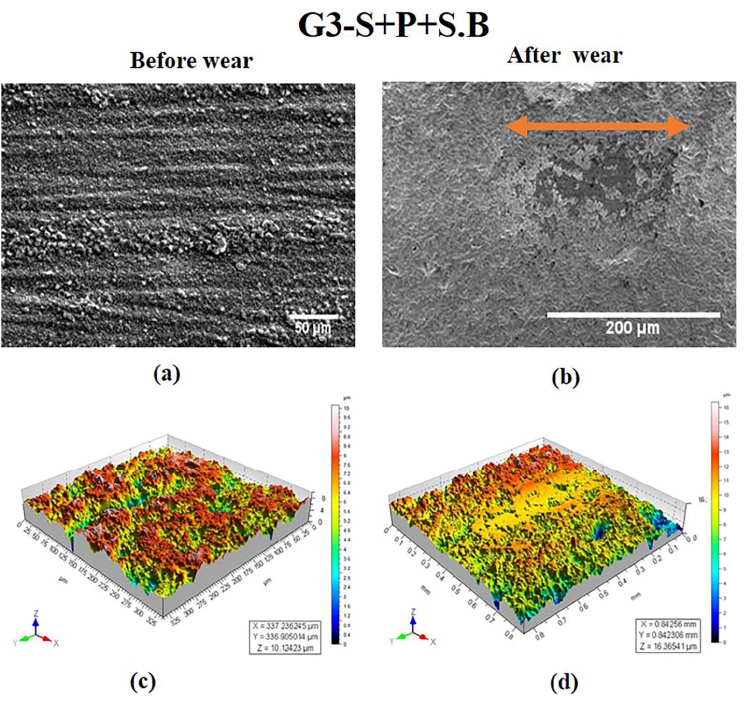
Figure 4. SEM images of specimen in G3 group at magnifications of ( a ) 50 µ m and ( b ) 200 µ m. 3-D surface morphology profile ( c ) before wear ( d ) after wear. Wear track is indicated by arrow.